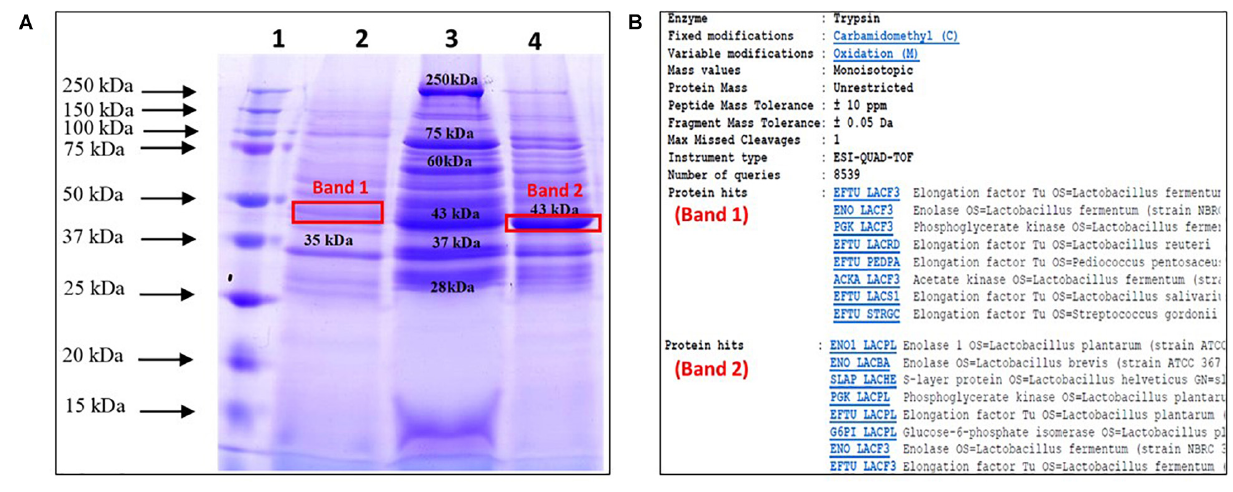
FIGURE 1 | Profiling, identification, and endotoxin determination of surface proteins from test probiotic strains; (A) SDS-PAGE profile of surface proteins extracted using LiCl method (Lane 1, Ladder; 2, L. plantarum MTCC 5690; 3, L. acidophilus NCFM; 4, L. fermentum MTCC 5698); (B) Identification of selected protein bands using mass